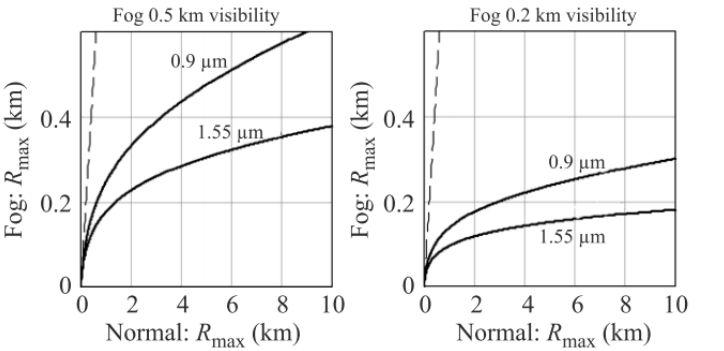
Figure 12. Range degradation curve observed when 905 nm and 1550 nm are subjected to 0.5 km and 0.2 km visibility